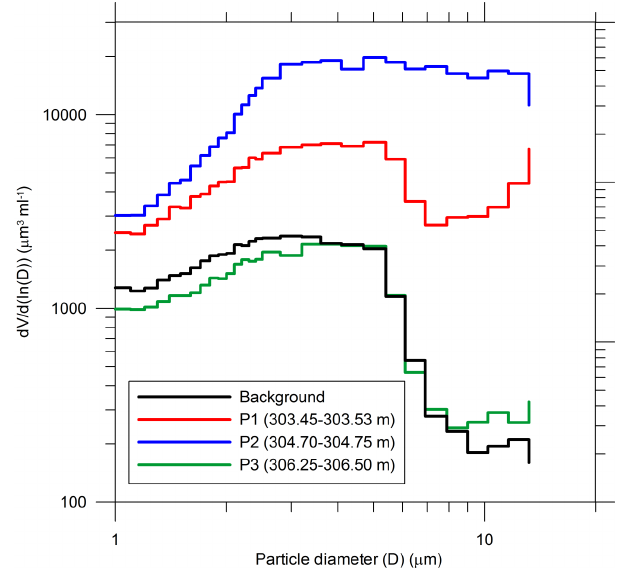
Figure 6. Dust volume distributions of average background dust and across the three prominent volcanic peaks, P1, P2, and P3 (see Fig. 2). The size distributions are obtained by an Abakus instrument that covers the particle size interval 1–15µm (spherical equivalent diameter). The Abakus is known not to measure dust sizes as accu- rately as a Coulter counter instrument (Ruth et al., 2003), and the shape of the dust size distribution may be somewhat biased. The relative sample differences in dust sizes are, however, robust and